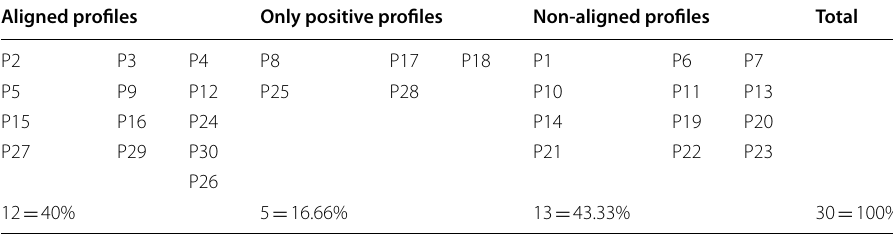
Table 5 Results showing which profiles are mostly aligned with the simulation results Aligned